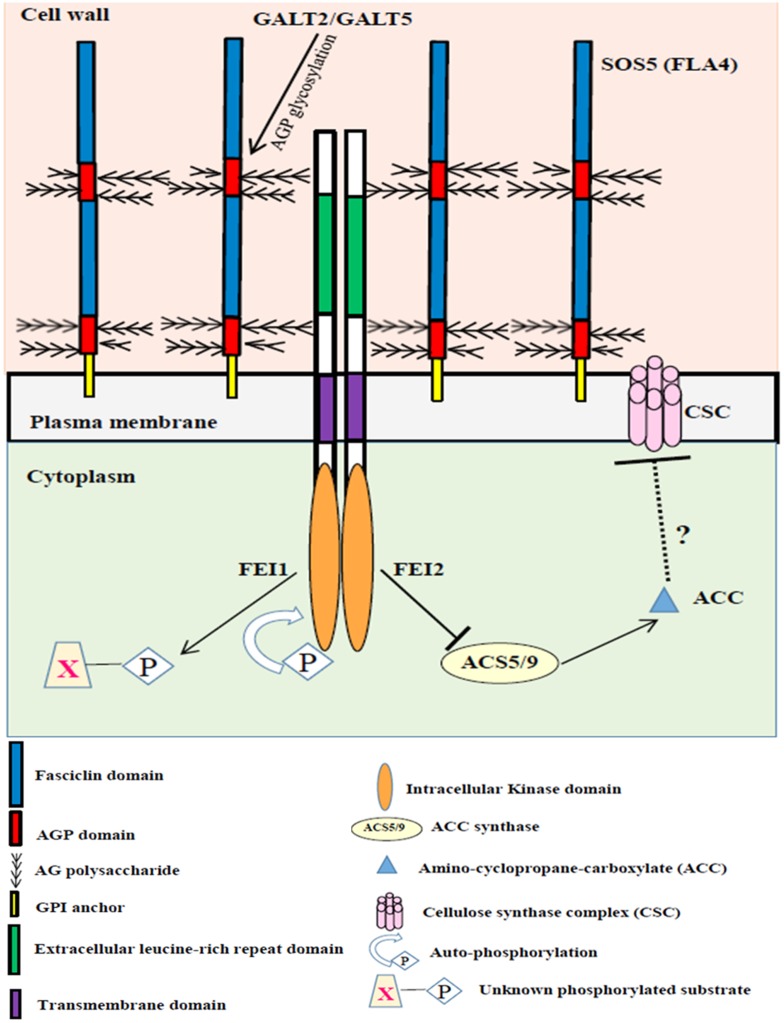
Proposed model linking GALT2 and GALT5 with SOS5 and FEI1/FEI2 in regulating cellular signaling of root growth.Signaling of normal root growth may involve GALT2/GALT5-dependent glycosylation of SOS5 and glycosylated SOS5 binding FEI1/FEI2, possibly inducing dimer formation and activation of the kinase domain as well as allowing for the binding of FEI1/FEI2 to ACC synthase. Such binding will inhibit the production of ACC, a potential signaling molecule and ethylene precursor, which directly or indirectly inhibits cellulose synthase/cellulose biosynthesis independent of ethylene. In contrast, when GALT2/GALT5-dependent SOS5 glycosylation is inhibited or SOS5 is mutated or FEI1/FEI2 is mutated, ACC synthase can no longer bind to FEI. Consequently, unbound ACC synthase produces ACC, which inhibits cellulose synthesis as well as leads to the production of ethylene.